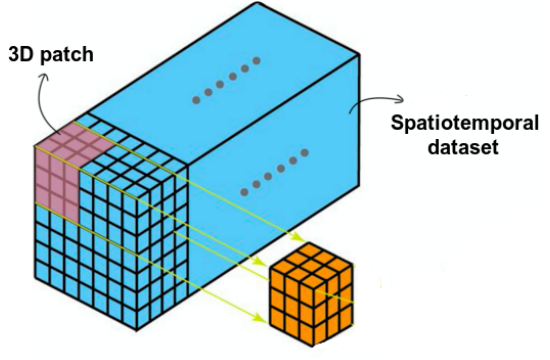
Figure 2. Patch-based strategy, where the whole spatiotemporal dataset is split into small patches. The temporal size of the patches corresponds to the length of the data assimilation window.